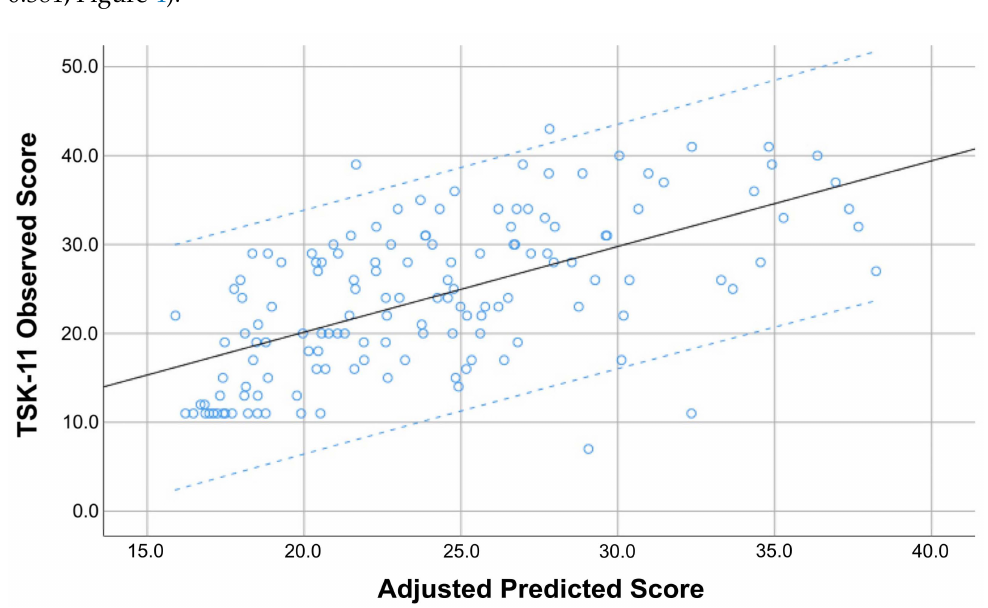
Figure 4. Scatter plot of the adjusted predicted score (r 2 adjusted: 0.381) explaining kinesiophobia levels (TSK-11) score in previously hospitalized COVID-19 survivors exhibiting “de novo” post- COVID pain symptoms ( n = 146). Note that some points can be